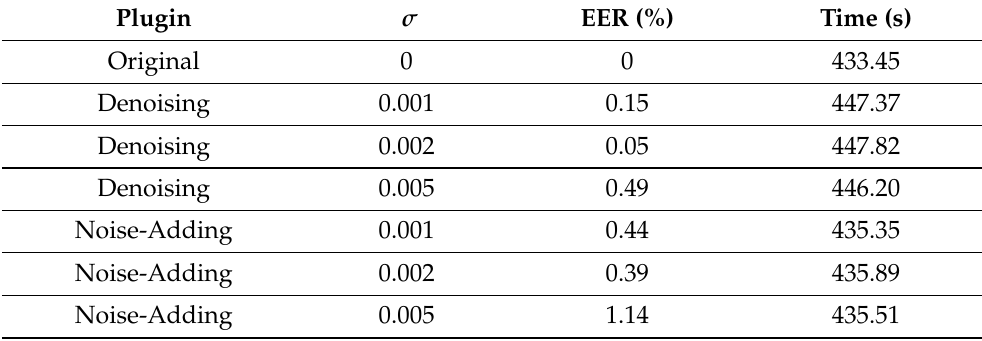
Table 2. Performance evaluation of proposed defense system on normal operations of I-Vector SV